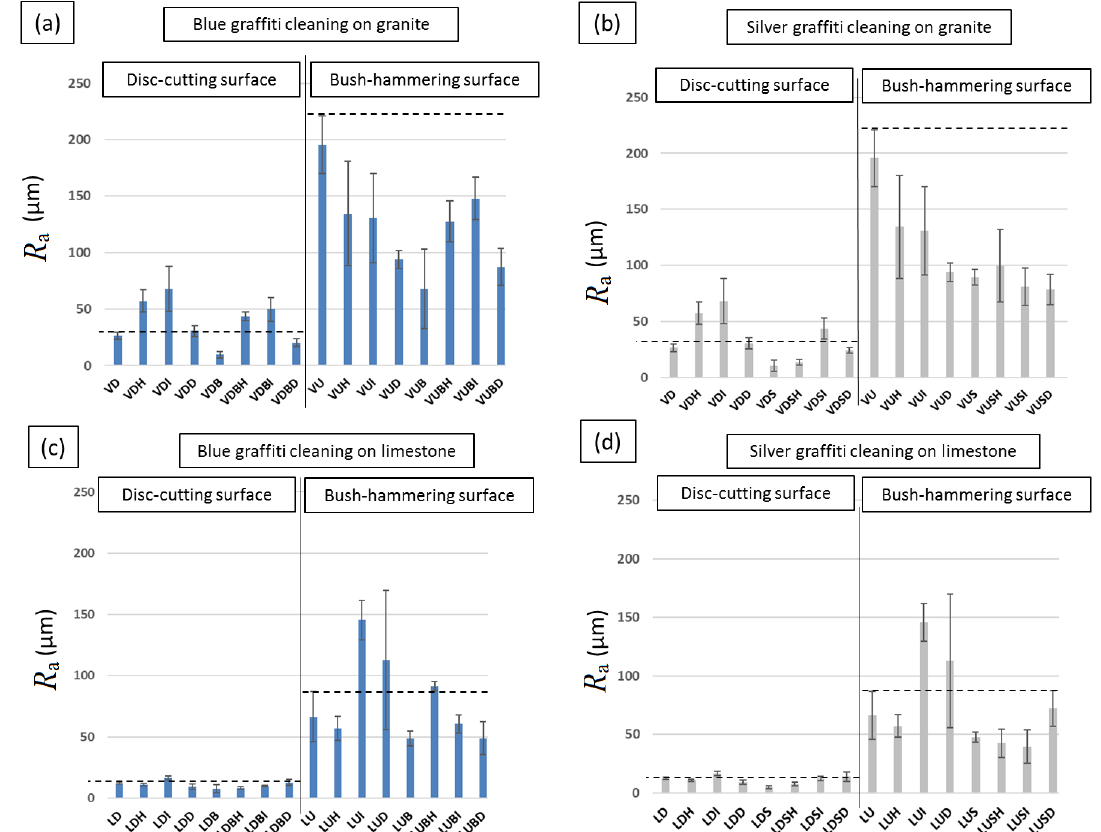
Figure 7. R a (arithmetic average of the roughness, µm) of the cleaned surfaces of blue and silver graffiti with Hydrogommage , IBIX, and dry-ice blasting. The roughness of the reference surface, the painted surface, and the surface after the application of the mechanical methods on unpainted surfaces are also provided. ( a ): Granite with blue graffiti. ( b ): Granite with silver graffiti. ( c ): Limestone with blue graffiti. ( d ): Limestone with silver graffiti. Standard deviation values are also shown. See Table 1 for samples’ nomenclature.